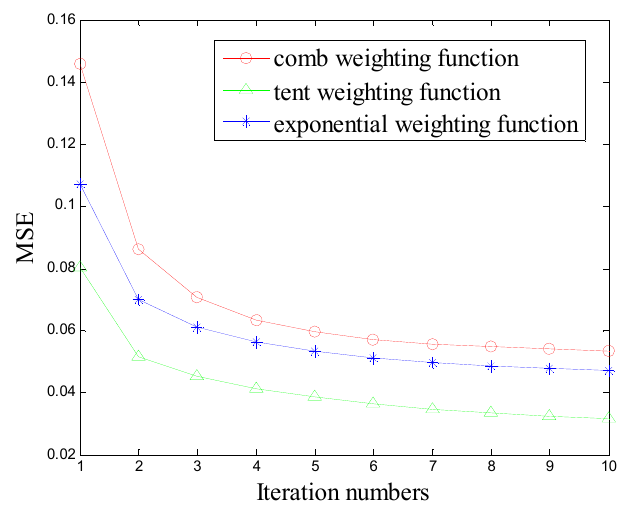
Figure 2. Similarity (C m ) values along with iterations.